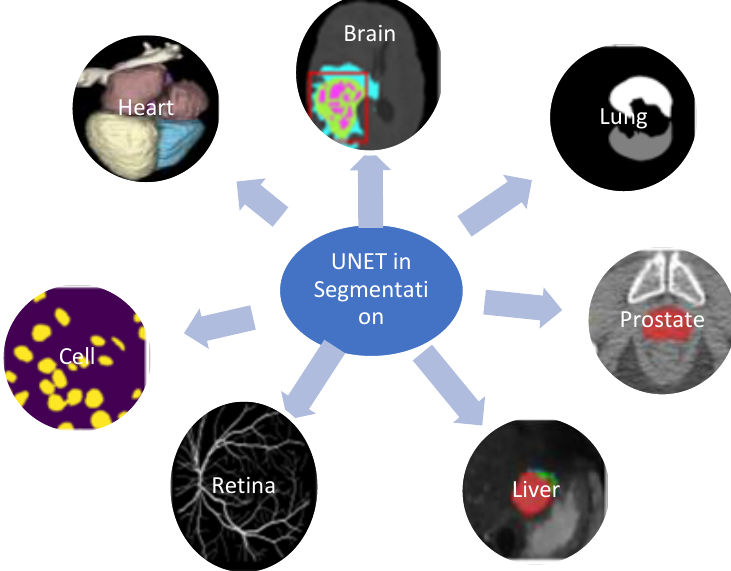
Figure 1. Application of UNET in medical image segmentation.